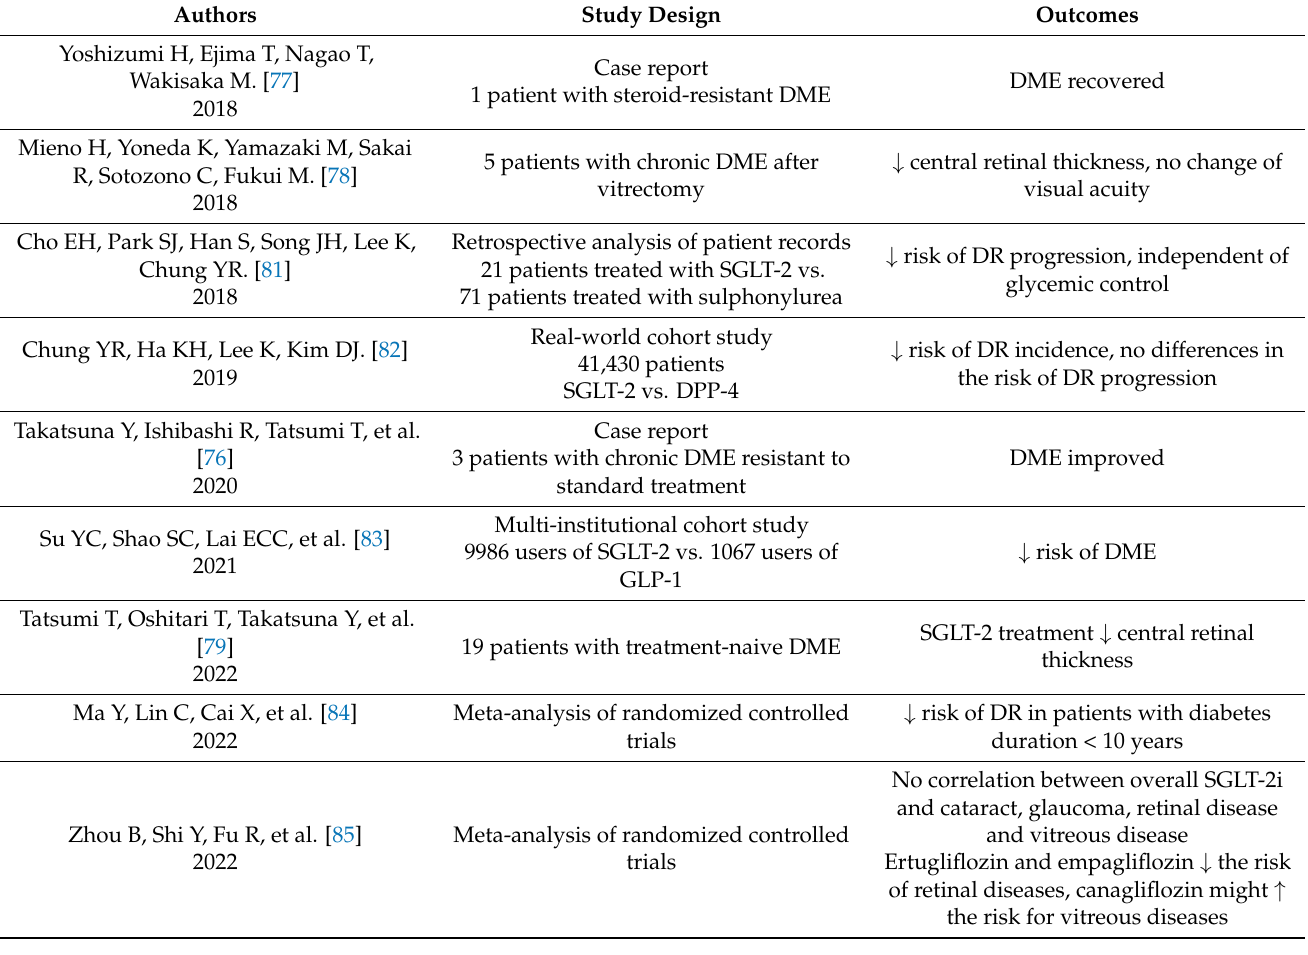
Table 4. Clinical trials assessing the effects of SGLT-2 inhibitors on